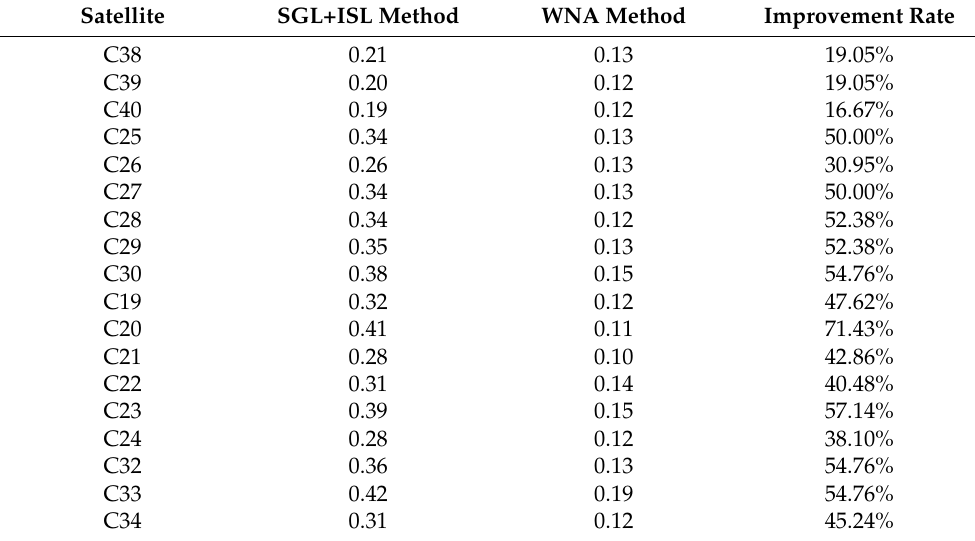
Table 1. RMS statistical results of fitting residuals (unit: ns).